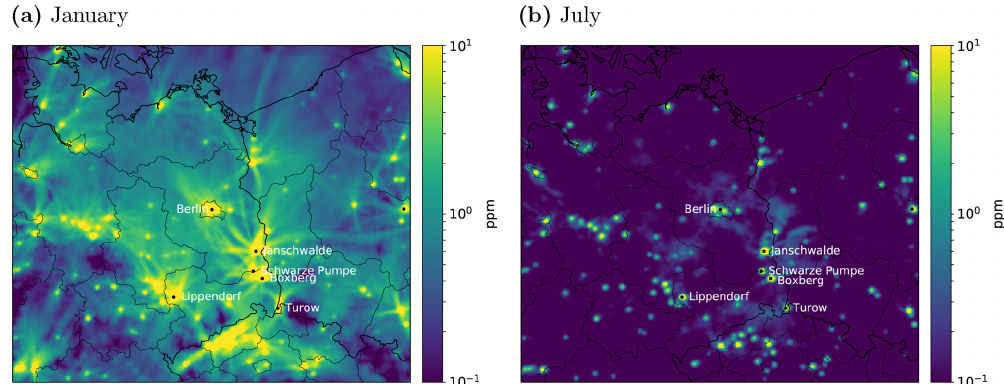
Figure 7. Difference in mean afternoon (14:00–16:00LT) near-surface CO 2 between tracers CO2_SURF and CO2_VERT in (a) January and (b)